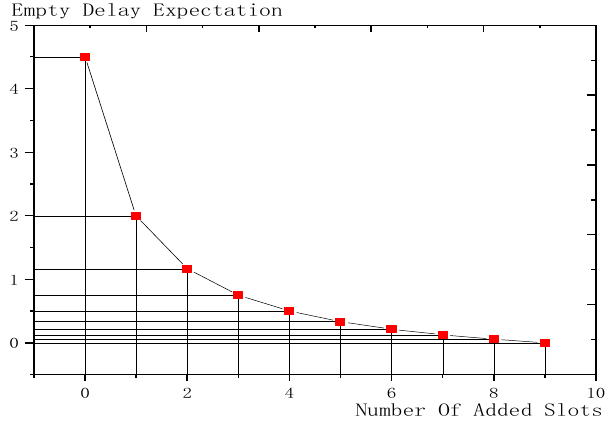
Figure 11. The trend chart of the effect of added slots on empty delay ( m = 10).